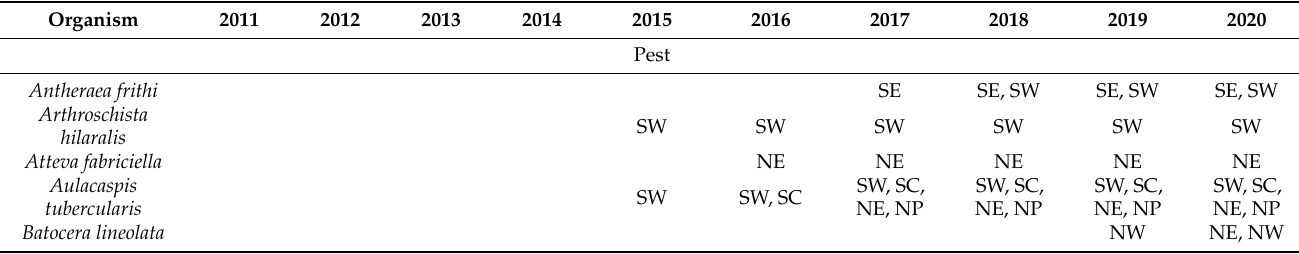
Table 3. Temporal and geographical occurrence of pest and pathogen species in forest health surveys in Vietnam from 2011 to